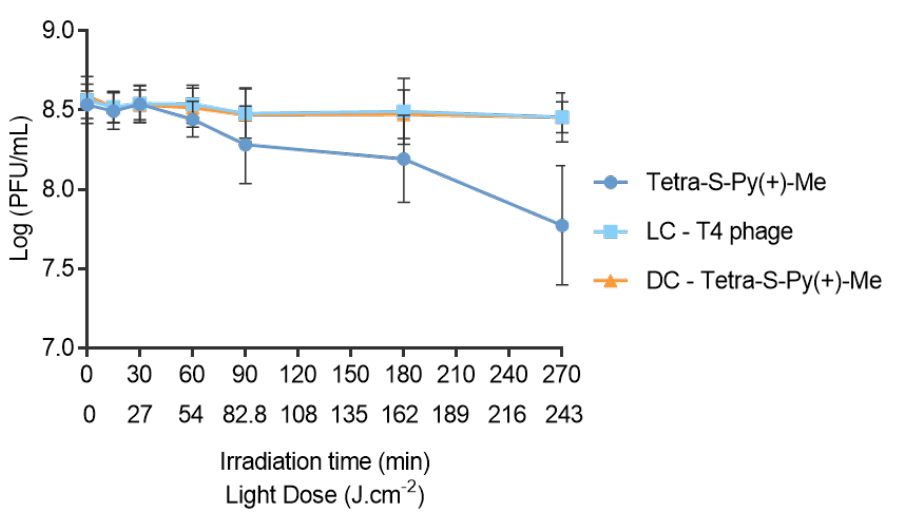
Figure 6. T4-like phage photoinactivation in whole blood in the presence of Tetra-S-Py(+)-Me at 10 µM and under white light irradiation at an irradiance of 150 mW·cm − 2 . All values represent the average of three independent assays in duplicate. Error bars indicate the standard deviation. Lines were used to connect the data points. LC—Light control; DC—Dark